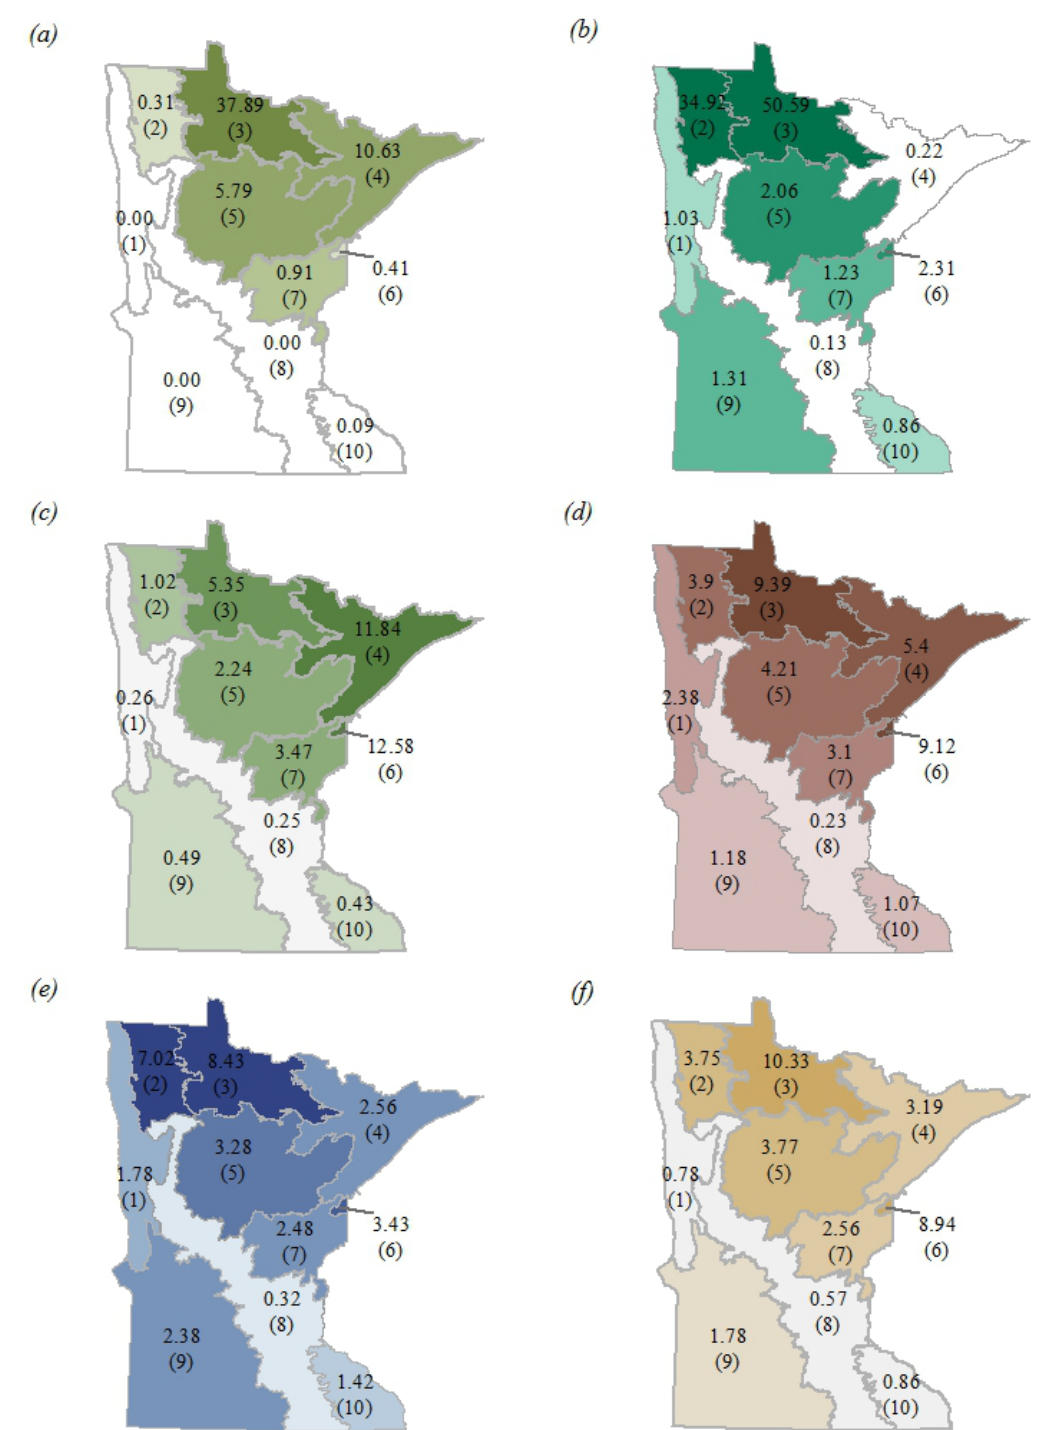
section. The Minnesota and Northeast Iowa Morainal (RLQ = 0.25) and Red River Valley (RLQ = 0.25) have the lowest scores. Figure 3. Population based RLQs for ( a ) forestland, ( b ) nature preserve, ( c ) parkland, ( d ) summer trails, ( e ) winter trails, and ( d )